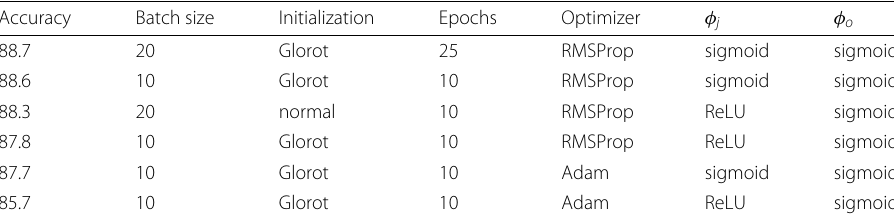
Table 2 Grid search for hyperparameters